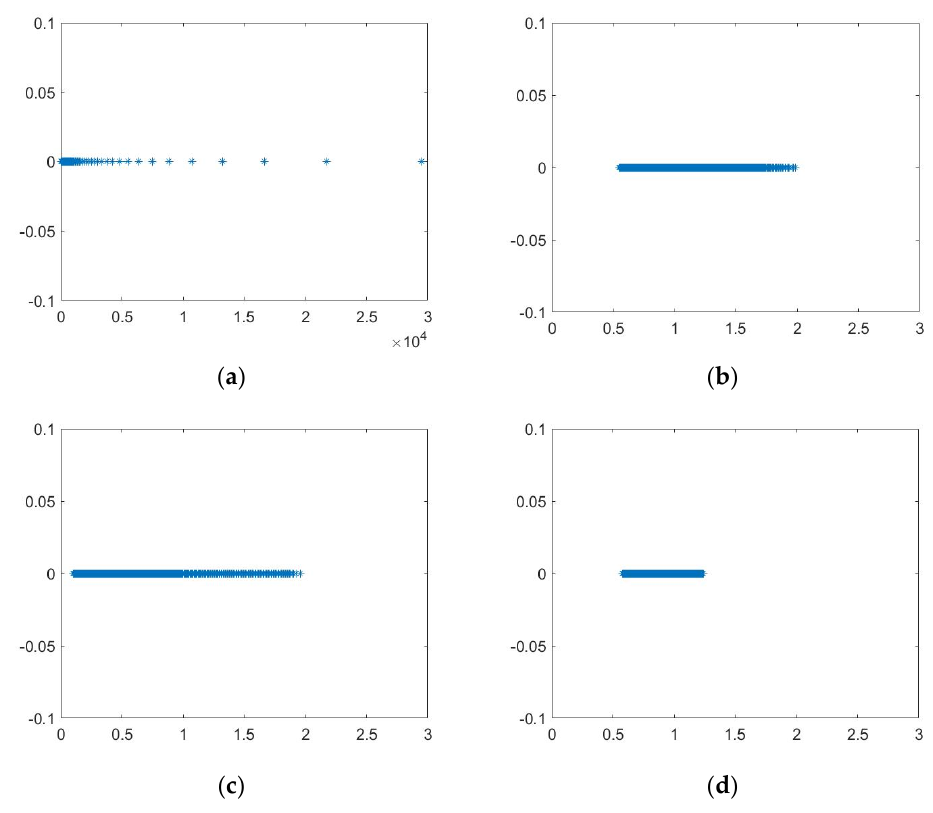
Figure 1. The eigenvalues of the matrix A ( a ), DCS preconditioned matrix ( b ), DTS τ preconditioned matrix ( c ) and FMDTS preconditioned matrix ( d ) of Example